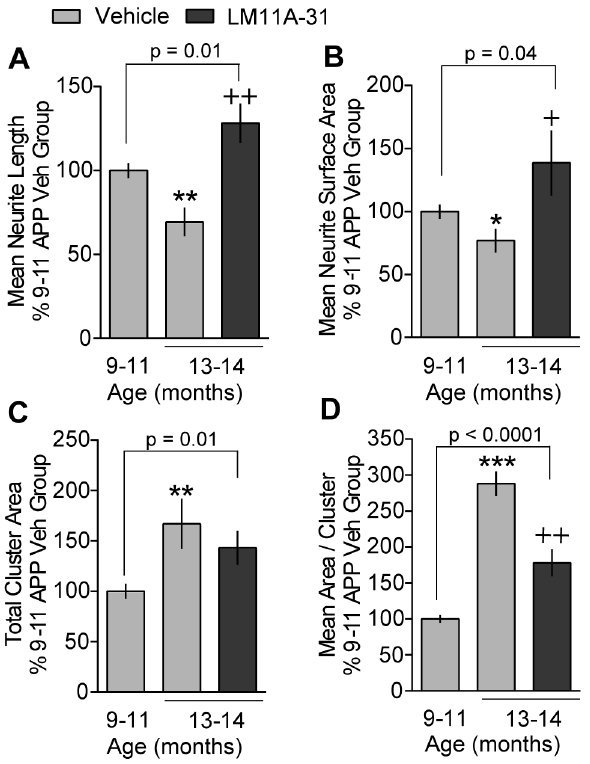
Figure 9. LM11A-31 reverses dystrophy of cholinergic neurites that occurs with aging in APP L/S mice. Quantitative analysis of the effect of aging showed that 13–14 month old vehicle-treated APP L/S (APP) mice had ChAT neurites in basal forebrain with decreased ( A ) length and ( B ) area and had dystrophic neurite clusters in cortex that occupied more area ( C ) and were larger ( D ) compared to the 9–11 month old APP Veh mice. In 13–14 month old APP mice, LM11A-31 increased the length and area of ChAT neurites in basal forebrain while decreasing the area of cortical dystrophic neurites compared to vehicle- treated mice ( A–D ; absolute numbers shown in Figs. 4 and 5). The effect of LM11A-31 in the basal forebrain was a reversal as neurite length ( A ) and area ( B ) were significantly greater in 13–14 month old APP-31 mice than 9–11 month old APP Veh mice. In the cortex, LM11A- 31 did not reverse the area occupied by dystrophic neurites as 13–14 month old APP-31 mice still had significantly larger clusters than 9–11 month old APP Veh mice ( C,D ). Results are expressed as a percentage of the 9–11 month old APP Veh group. Statistical significance was determined using one-tailed Student’s t-test (For 9–11 month old APP Veh n=10; For 13–14 month group: APP Veh, n=4; APP-31, n=5). * p # 0.05, ** p # 0.005 and *** p # 0.001 vs. 9–11 month old APP Veh; + p # 0.05 and ++ p # 0.01 vs. 13–14 month old APP Veh.